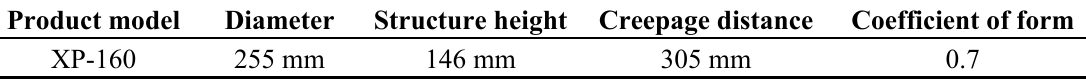
Table 3. Parameters of test samples (mm).